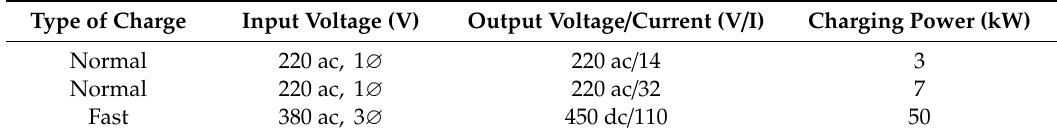
Table 2. Charger specifications used for modeling PEV charging